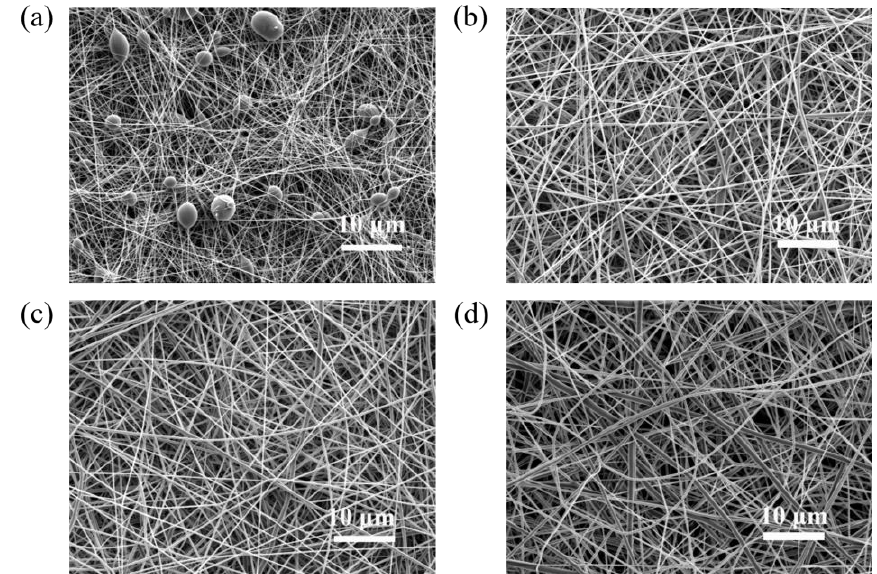
Figure 1. SEM micrographs of electrospun fibers prepared with different concentration spinning solutions. ( a ) 12 wt.%, ( b ) 20 wt.%, ( c ) 24 wt.%, ( d ) 28 wt.%.